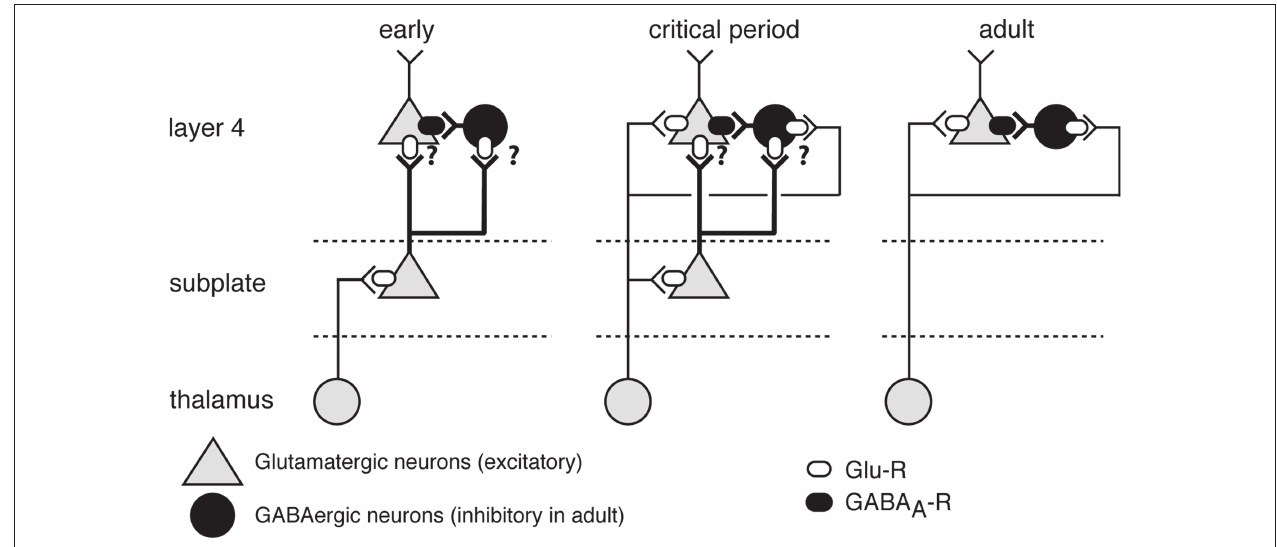
FIGURE 1 | Subplate neurons and their connectivity during development. Early: subplate neurons (green) receive inputs from thalamus and subplate neuron axons project to layer 4, but precise targets are unknown (‘?’). Onset of critical period (coincides with time of subplate ablation in lesion studies): Both subplate neurons and thalamus project to layer